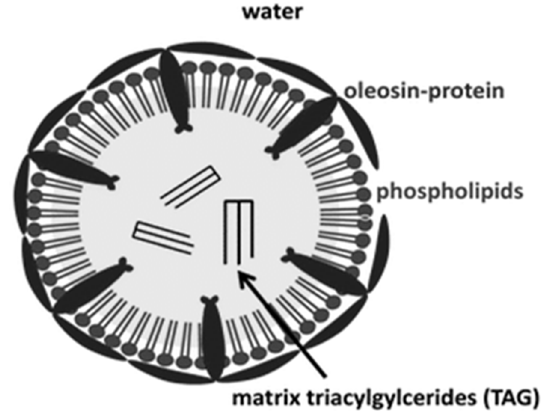
Figure 6. Schematic demonstration of an oleosome vesicle structure [33].